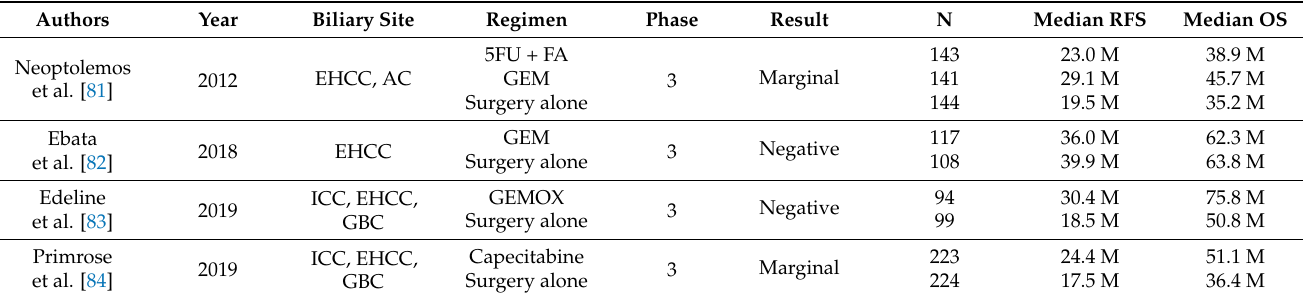
Table 3. Randomized controlled studies of adjuvant chemotherapy for resected biliary tract